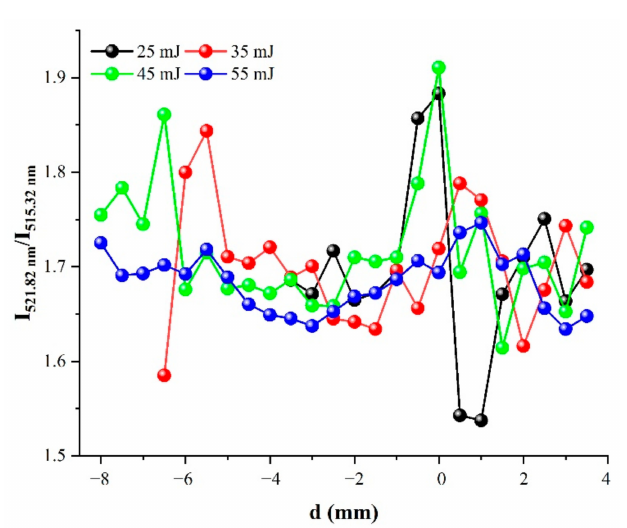
Figure A1. Effect of pulse energies and d on the experimental intensity ratio I 521.82 nm /I 515.32 nm